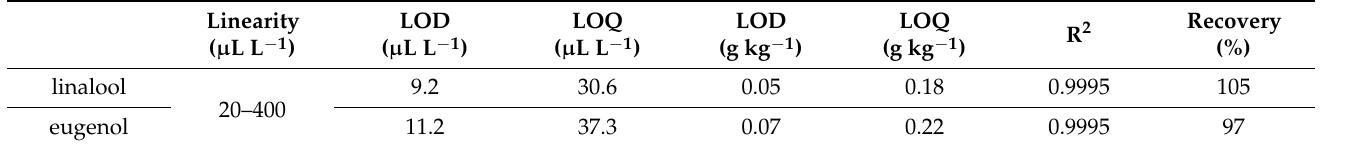
Table 1. Linearity, LOD and LOQ referred to standard solution ( µ L L − 1 ) and referred to the sample powder (g kg − 1 ) and recovery of eugenol and linalool from basil